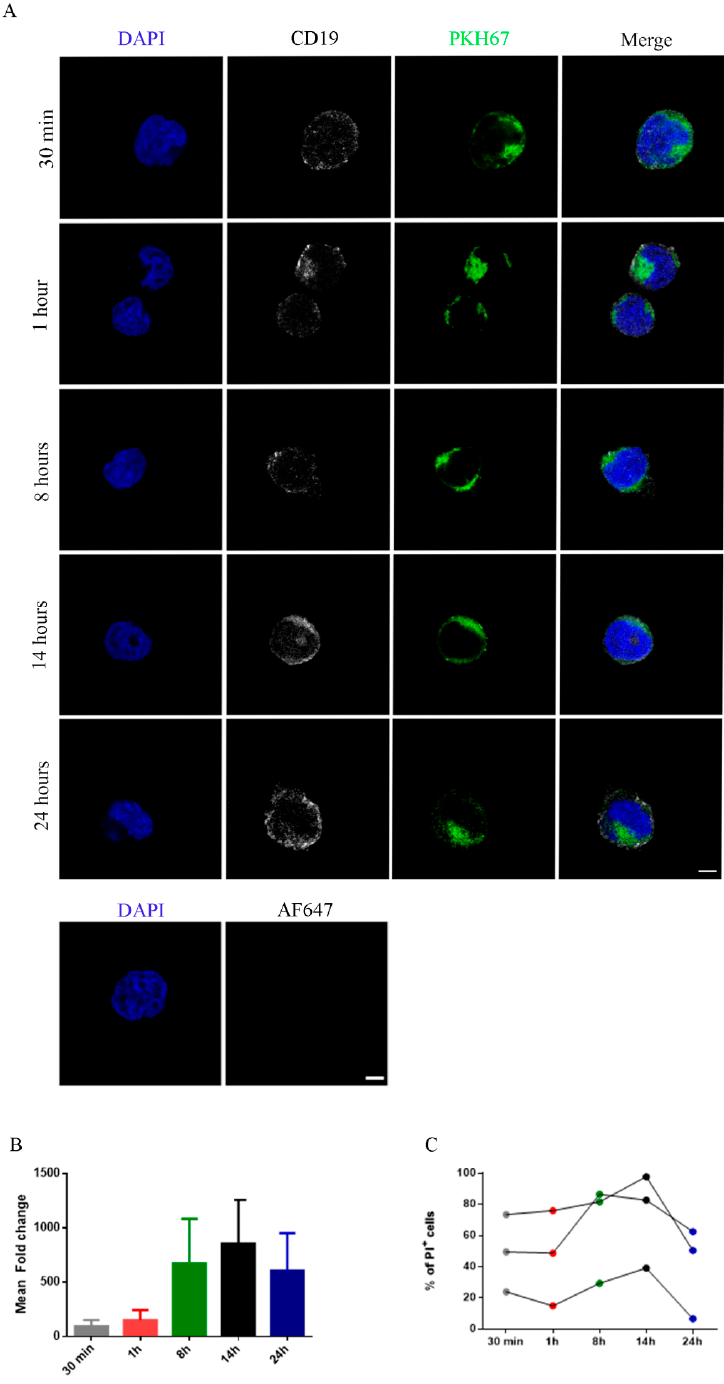
Figure 3. Uptake of PKH67 + NK-derived exosomes to NALM-18 lymphoma cell line. ( A ) Confocal microscopy analysis of exosome internalization by NALM-18 target cells at different time points (30 min, 1 h, 8 h, 14 h, and 24 h). Cells, stained with anti-CD19 antibody (white) and DAPI (blue), were incubated with 20 µg of PKH67-labelled NK exosomes (green) and their internalization was evaluated at different times (Upper figure). Bar: 5 µm. NALM-18 cells, stained with DAPI (blue) and incubated with Alexa Fluor 647 conjugated secondary antibody as control for antibody specificity. (Lower figure) Bar: 5 µ m. ( B ) Exosome uptake evaluation by flow-cytometry. Fluorescence intensities of PKH + NALM-18 cells are shown as mean fold change ( n = 3). ( C ) Percentage of PI + NALM-18 cells treated at di ff erent time points (30 min, 1 h, 8 h, 14 h, and 24 h) using 20 µ g of NK-exosomes ( n =